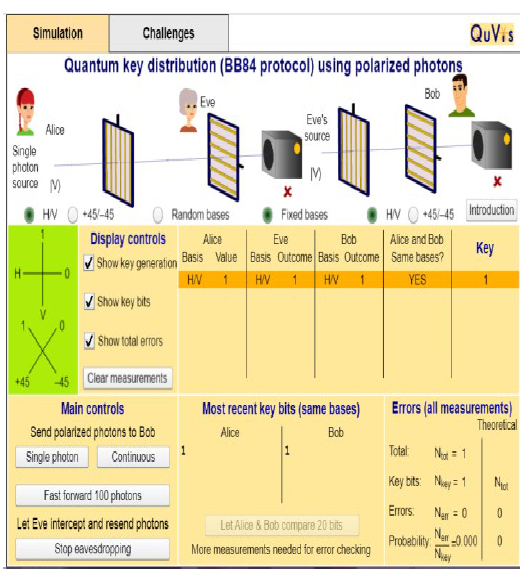
Fig ure 7. Simulations with Malicious